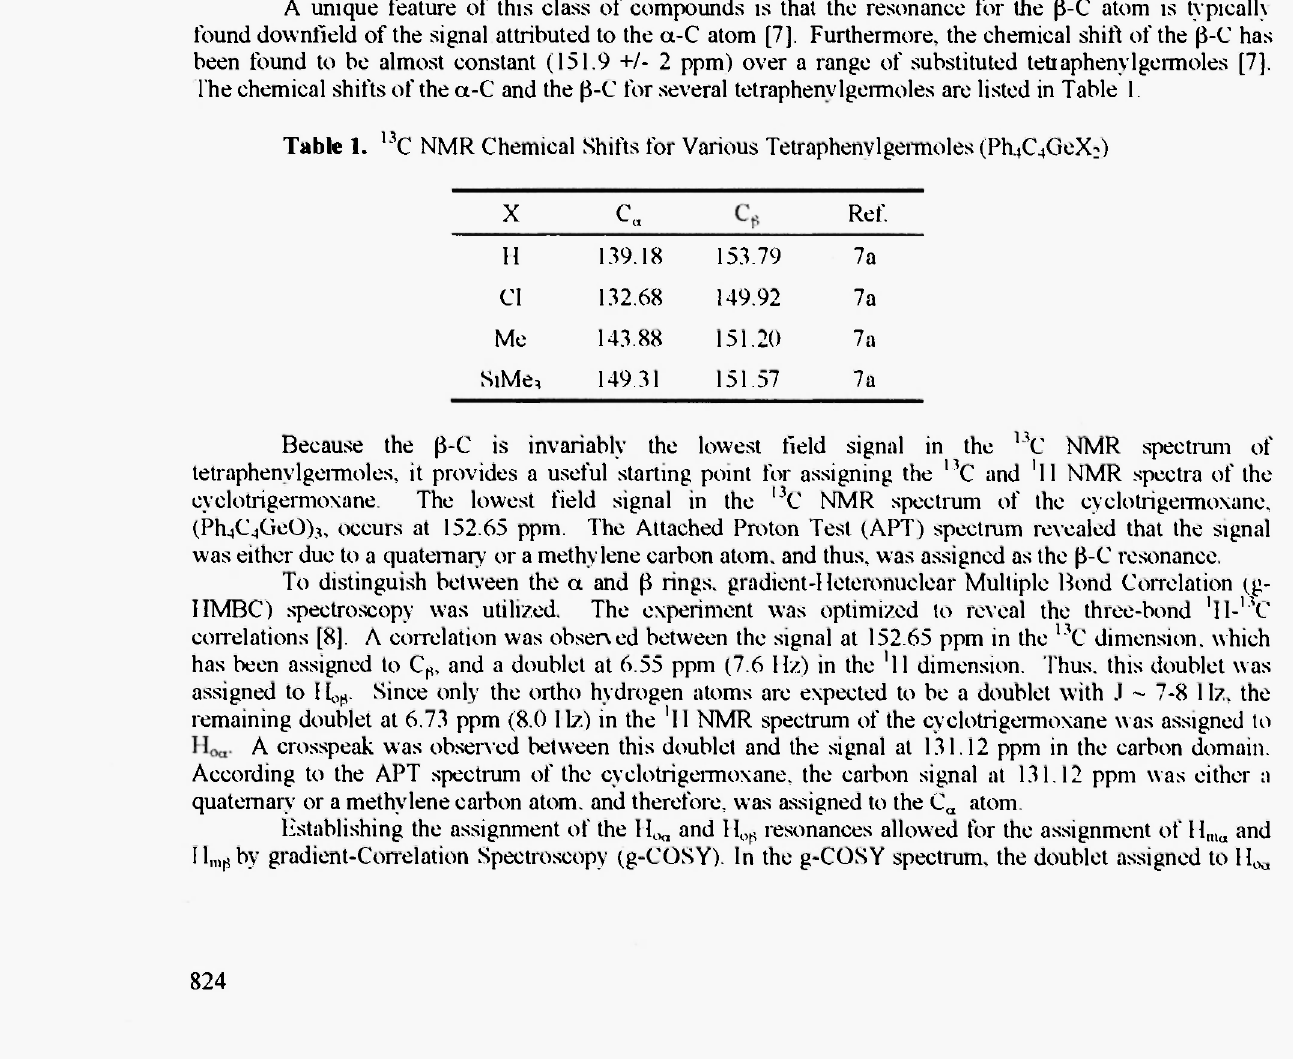
Figure 2. The Chemically Distinct 'l l and 13 C Atoms of Tetraphenylgeimole Derivatives